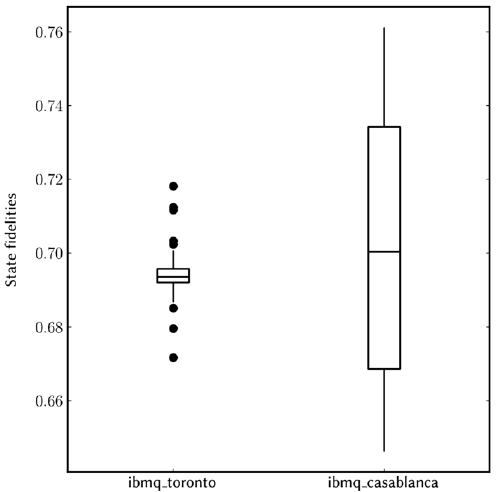
50 ) of state fidelities from the respective two devices showing the spread of Figure 8. Boxplot of a sample ( ν = the values around the sample mean and 95% confidence intervals.